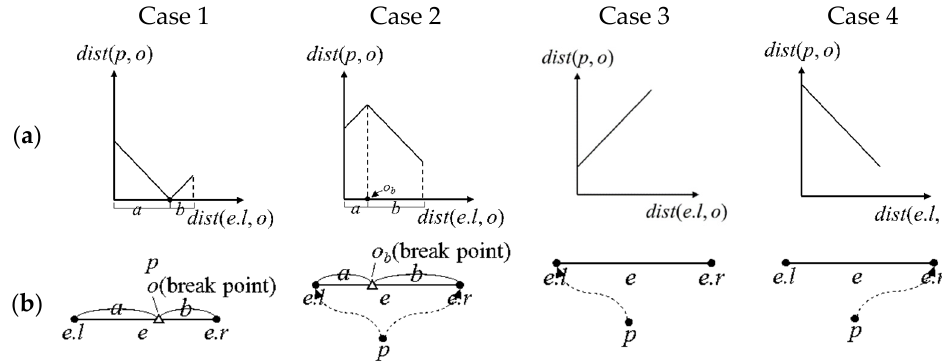
Figure 4. Four cases of dist ( p , o ): ( a ) graphs of dist ( p , o ); ( b ) corresponding road diagrams. CI ( Q , p ) is the influence score of p . For identical query sets, CI ( Q , p ) is constant. dist( p , o ) × CI ( Q , p ) can be regarded as a linear function or a piecewise linear function mul- tiplied by a constant, which results in a linear function or piecewise linear function.